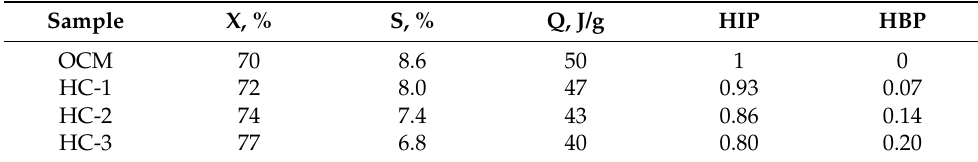
Table 3. Hydrophilic and hydrophobic properties of cellulose samples.